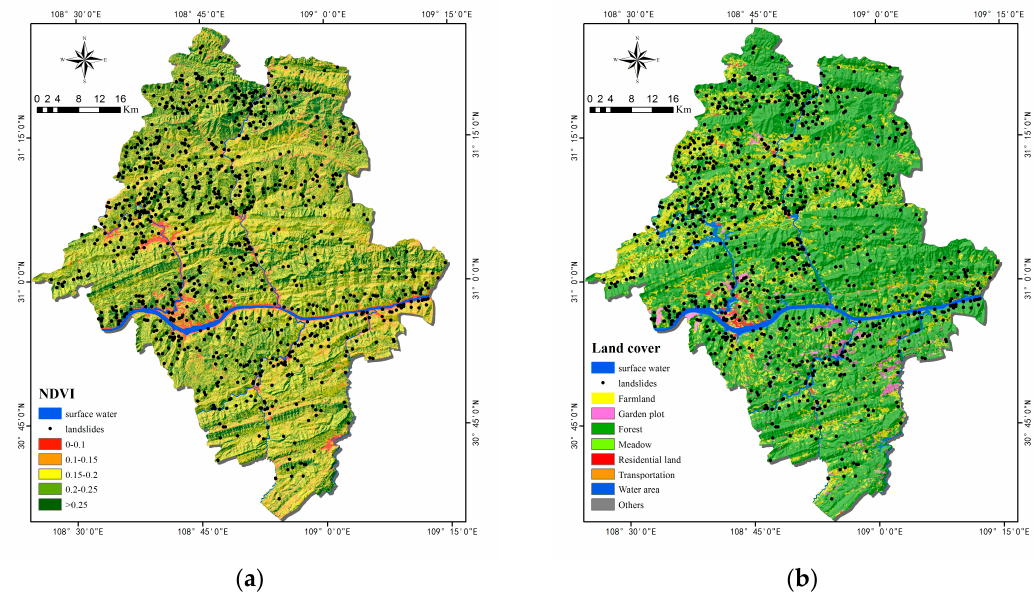
Figure 8. Thematic maps of environmental factors: ( a ) normalized vegetation index (NDVI); ( b ) Land cover.